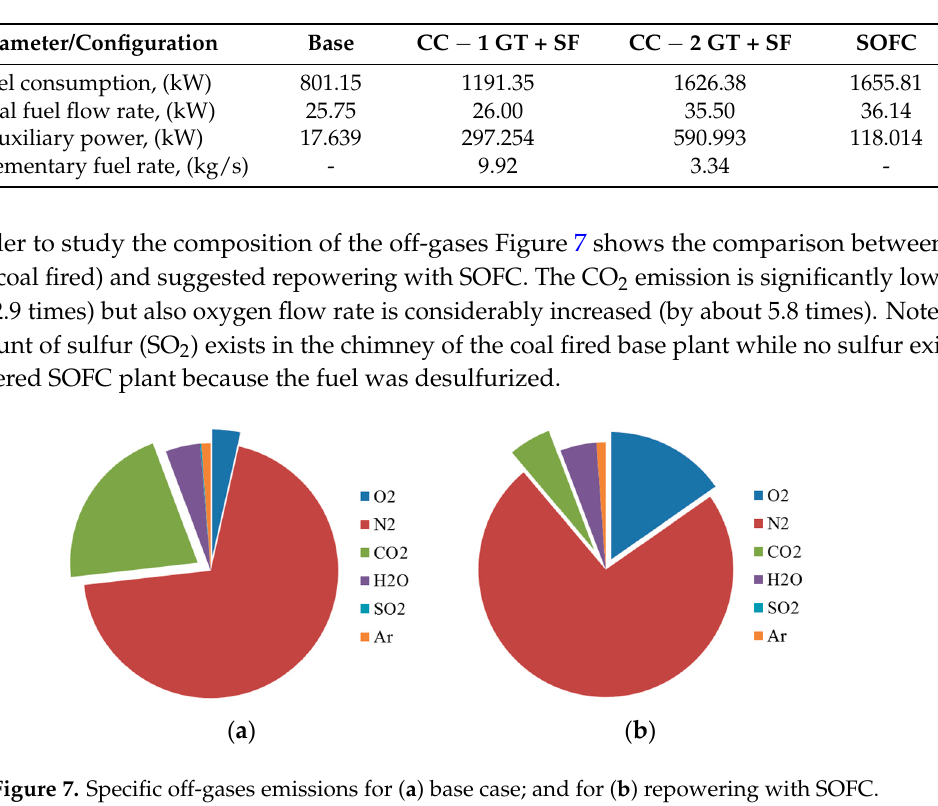
Table 6. Plant performance for different configurations.